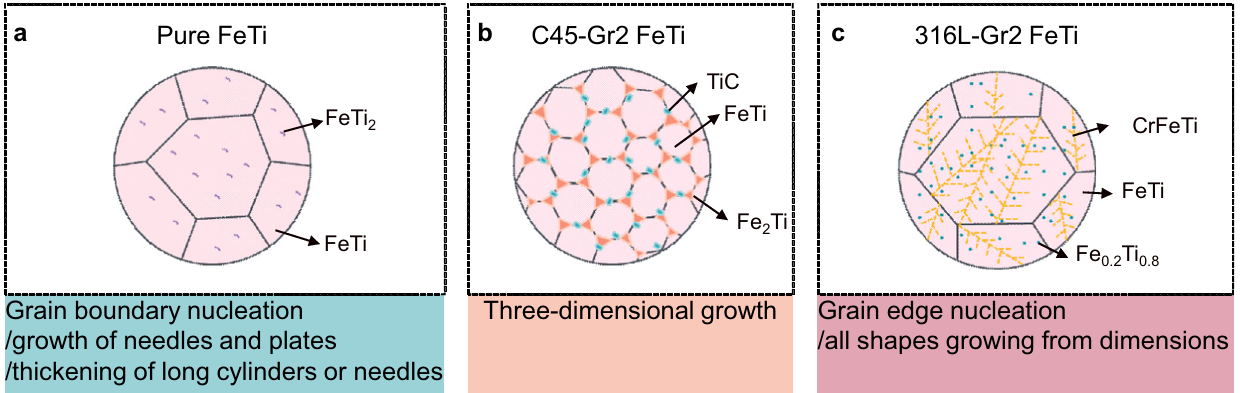
Fig. 6 Schematic sketches illustrating the hydrogenation mechanism of pure FeTi, C45-Gr2 FeTi, and 316L-Gr2 FeTi alloys. a hydrogenation mechanism of pure FeTi. b hydrogenation mechanism of C45-Gr2 FeTi. c hydrogenation mechanism of 316L-Gr2